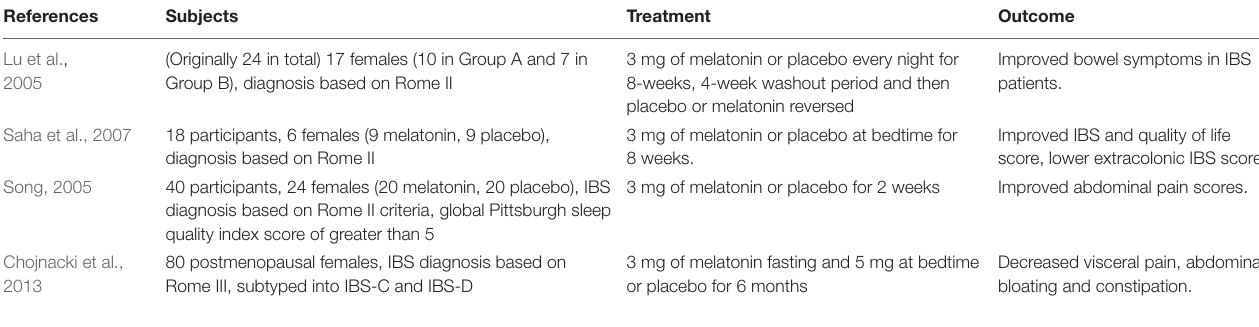
TABLE 1 | Randomised clinical trials looking at efficacy of melatonin in patients with